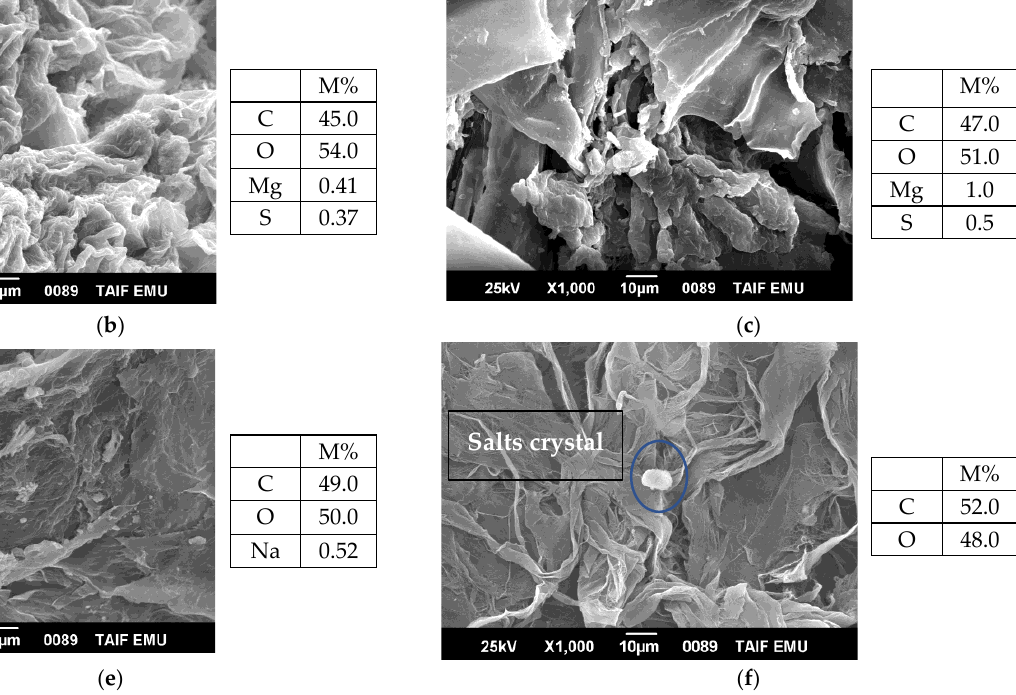
Figure 2. SEM and EDX analysis (see Supplementary Figure S1) showing various steps of cellulose nanocrystals production from C. linum with 1000 × magnification and operated at an accelerating voltage of 25 KeV. ( a ) w material: C. linum (CL-R) (Fine powder); ( b ) lkalinization treatment (CL-A4%) (4% NaOH); ( c ) Bleaching treatment (CL-B2.5%) (2.5% NaClO); ( d ) Alkalinization treatment (CL-A17.5%) (17.5% NaOH); ( e ) Bleaching treatment (CL-MCC) (2.5% NaClO); ( f ) Acid hydrolysis treatment (CL-CNC) (2.5N HCl).